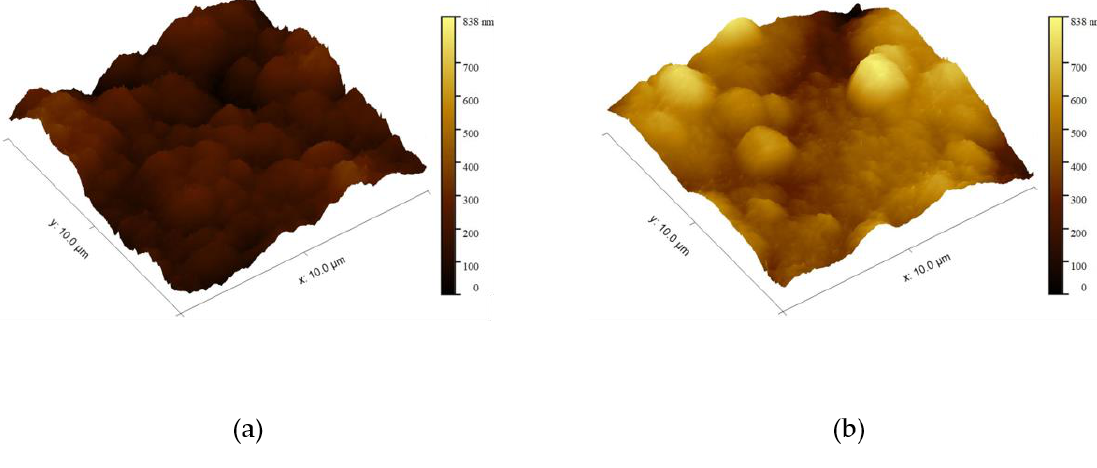
Figure 13. The 10 × 10 µm 2 3D atomic force microscopy (AFM) topography images of ( a ) NiSn-P3.3-alloy and ( b ) NiSn-rGO-P3.3.